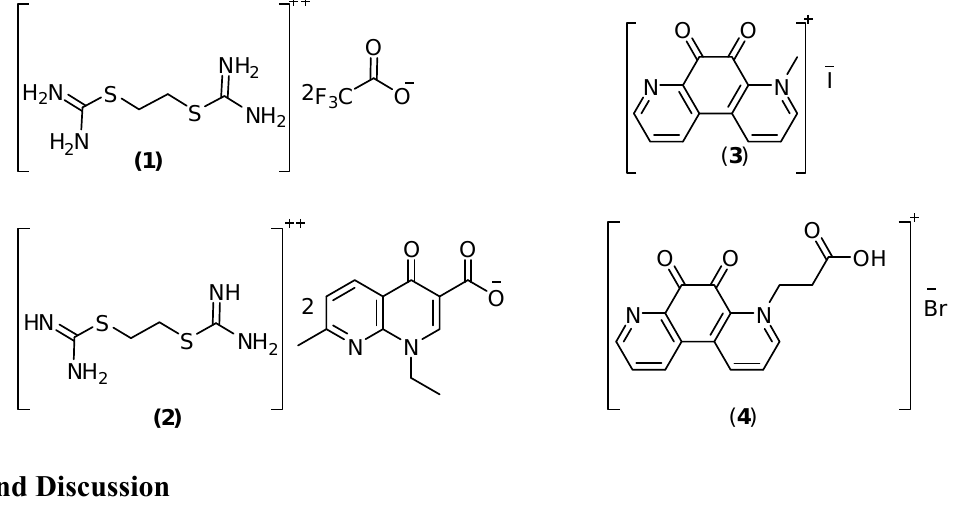
Figure 1. The chemical structure of the previously prepared isothiouronium salts